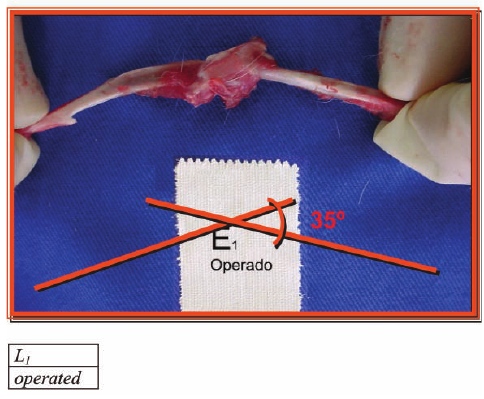
Figure 1 - Measurement of maximum extension